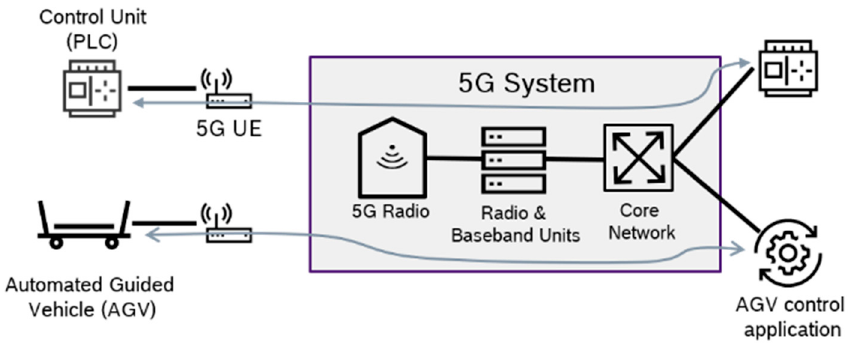
Figure 1. High-level architecture of the use cases realized in Reutlingen, where the arrows indicate the traffic flow between the PLCs in the TSN/Industrial LAN over 5G use case and the AGV and its control application in the cloud-based mobile robotics use case. Source: